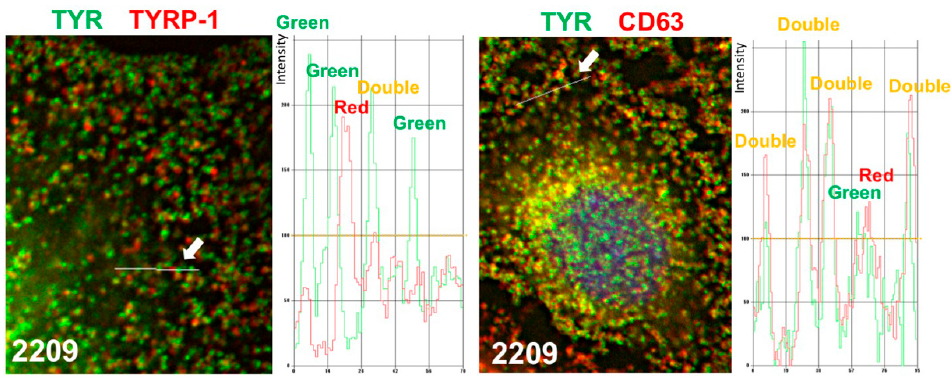
Figure 9 . Examples of the categorization of spots (vesicles) into three groups, double positive and single positive (green or red).